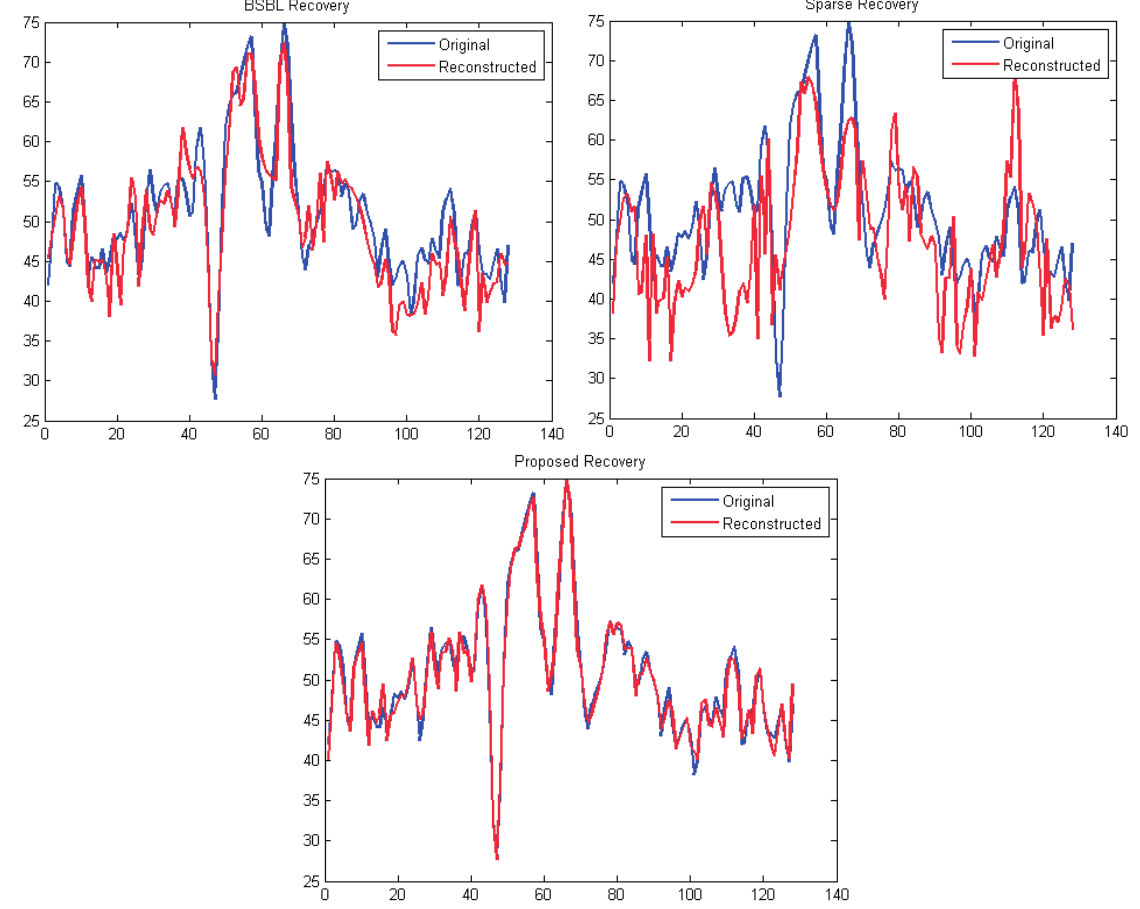
Figure 6. Overlayed original and reconstructed signals from different techniques (BSBL, sparse reconstruction and proposed). Sampling instants (time points) on the X -axis and signal amplitude on the Y